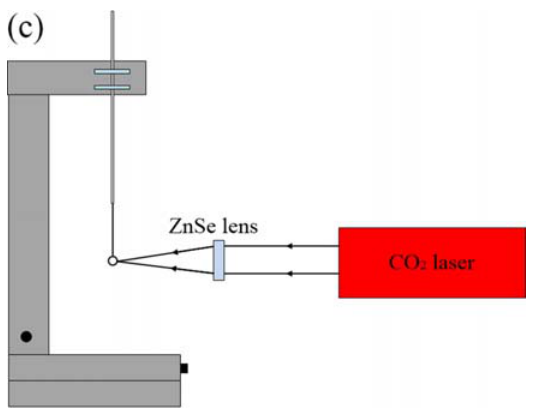
Figure 1. Schematic diagram of the experimental setup for making a silica microsphere. ( a ) A ZnSe lens is used to focus a CO 2 laser beam on the silica fiber; ( b ) the waist region of tapered fiber is cleaved; ( c ) a silica microsphere is obtained by focusing a CO 2 laser beam on the end of the cleaved tapered fiber.